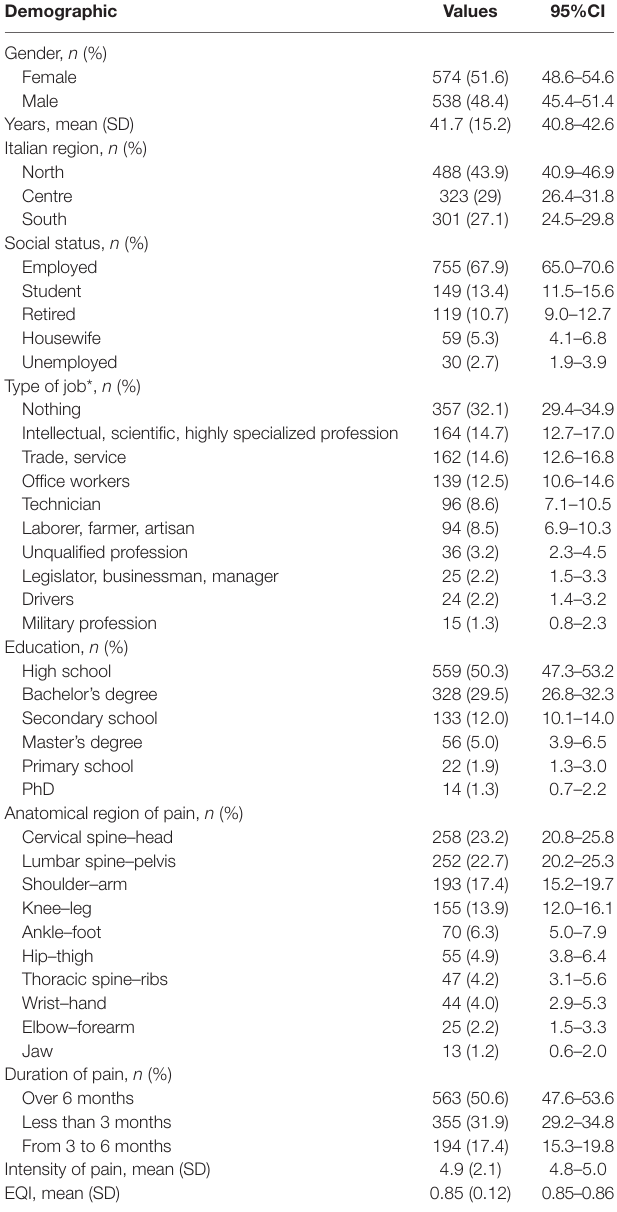
TABLE 1 | Participant characteristics ( n =